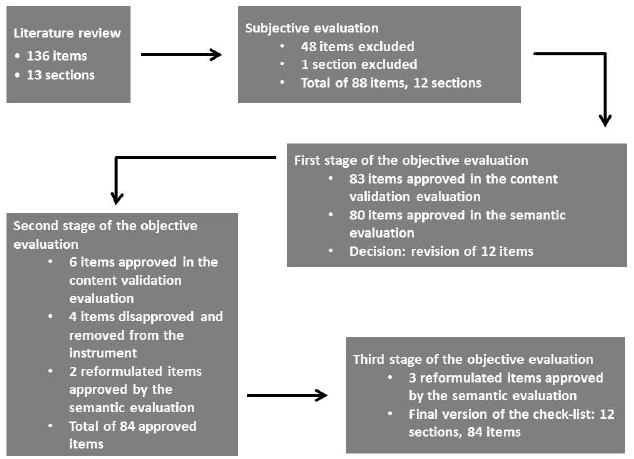
Figure 1. Stages of the content validation and semantic evaluation processes.